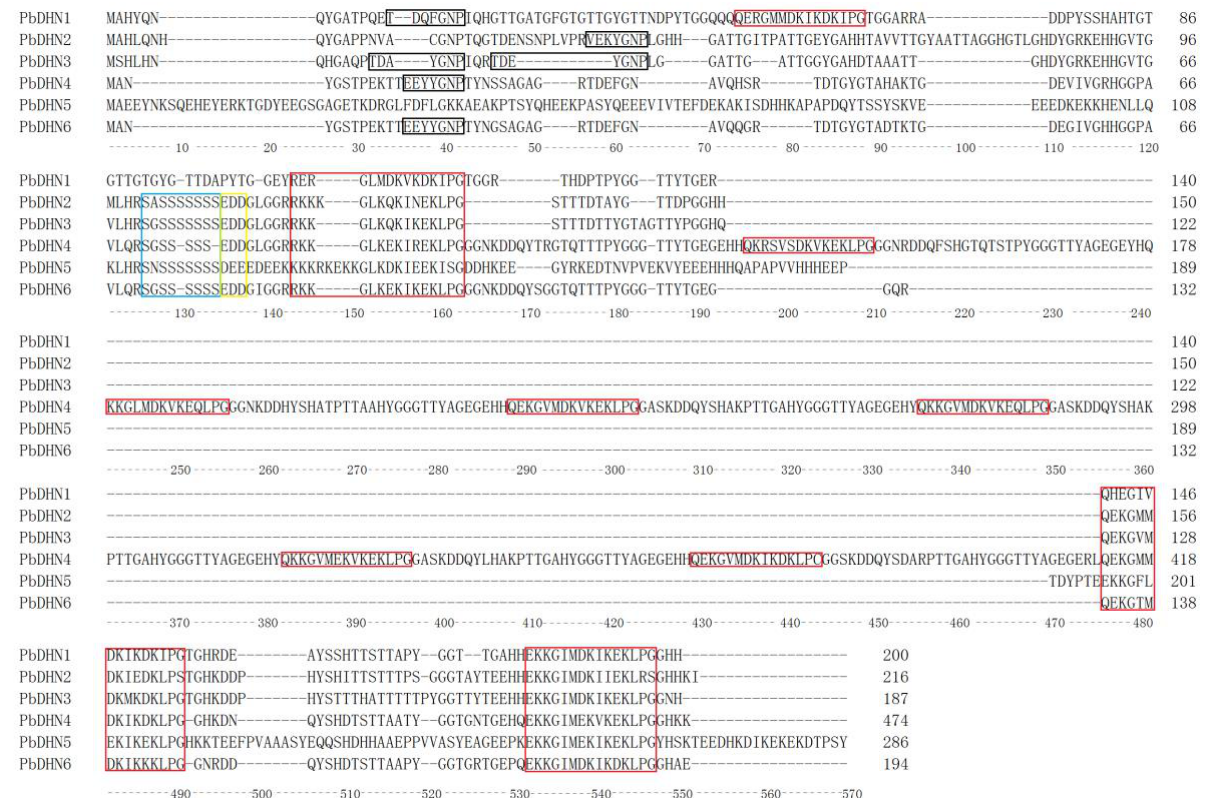
Figure 1. Alignment of multiple amino acid sequences of PbDHNs in ‘Huangguan’ pear fruit. The sequences in black boxes indicate Y-segment, the sequences in the blue box indicate S-segment, the sequences in red boxes indicate K-segment, and the sequences in the yellow box indicate phosphorylation